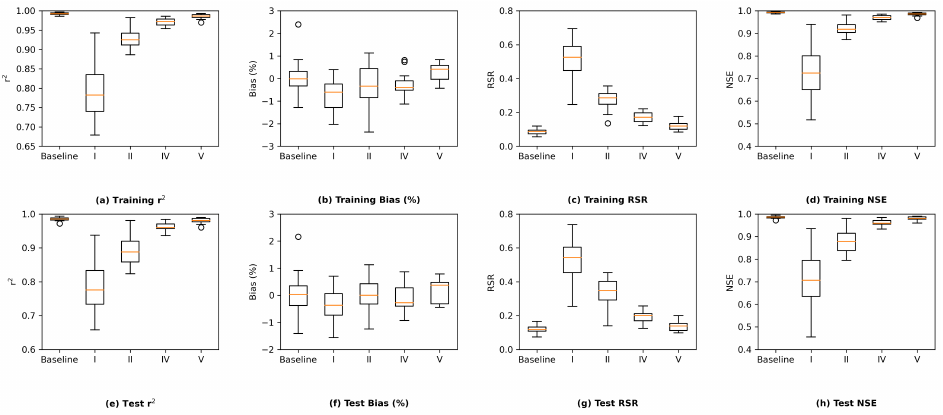
Figure A10. Box and whisker plots of four types of metrics consisting of r 2 , percent bias, RSR, and NSE on stations belonging to the interior Delta group during the training (panels ( a – d )) and test (panels ( e – h )) phases of the grouped (G) LSTM model under five scenarios: baseline and four different memory lengths as presented in Table 1.